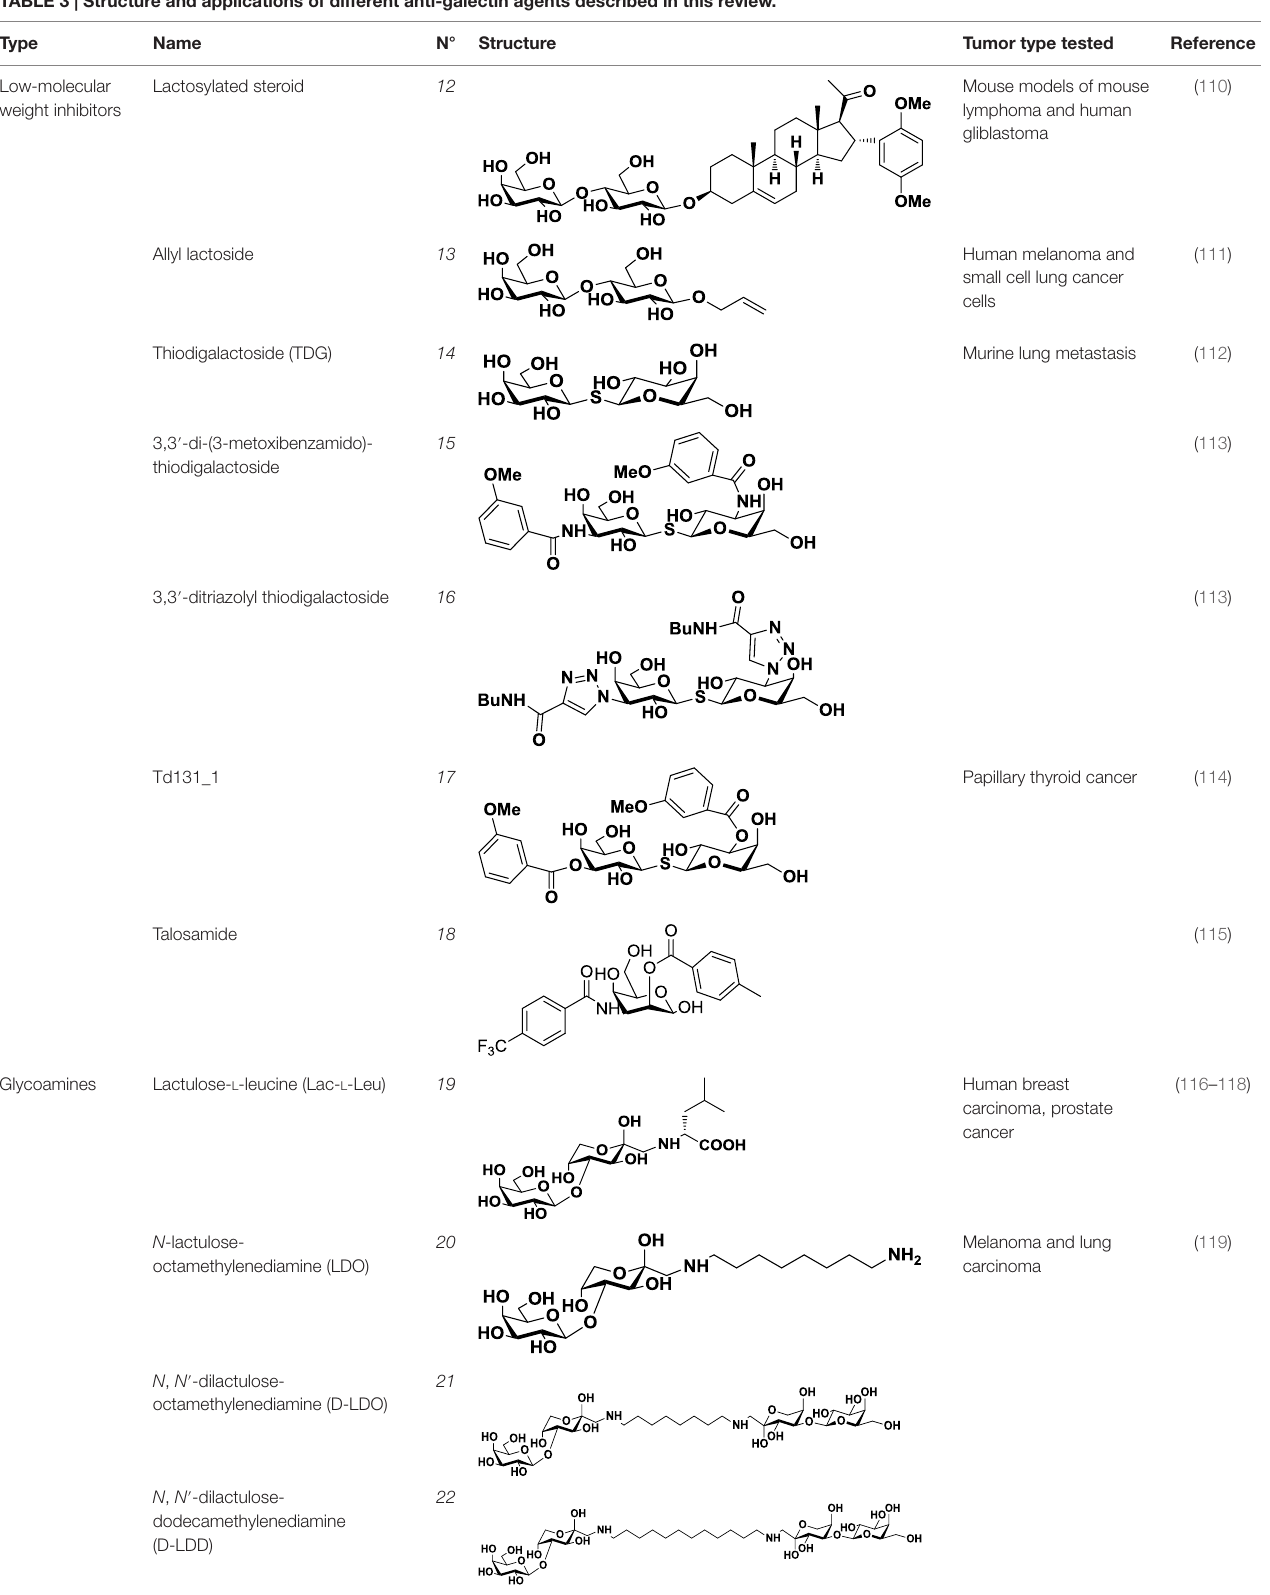
TABLe 3 | Structure and applications of different anti-galectin agents described in this